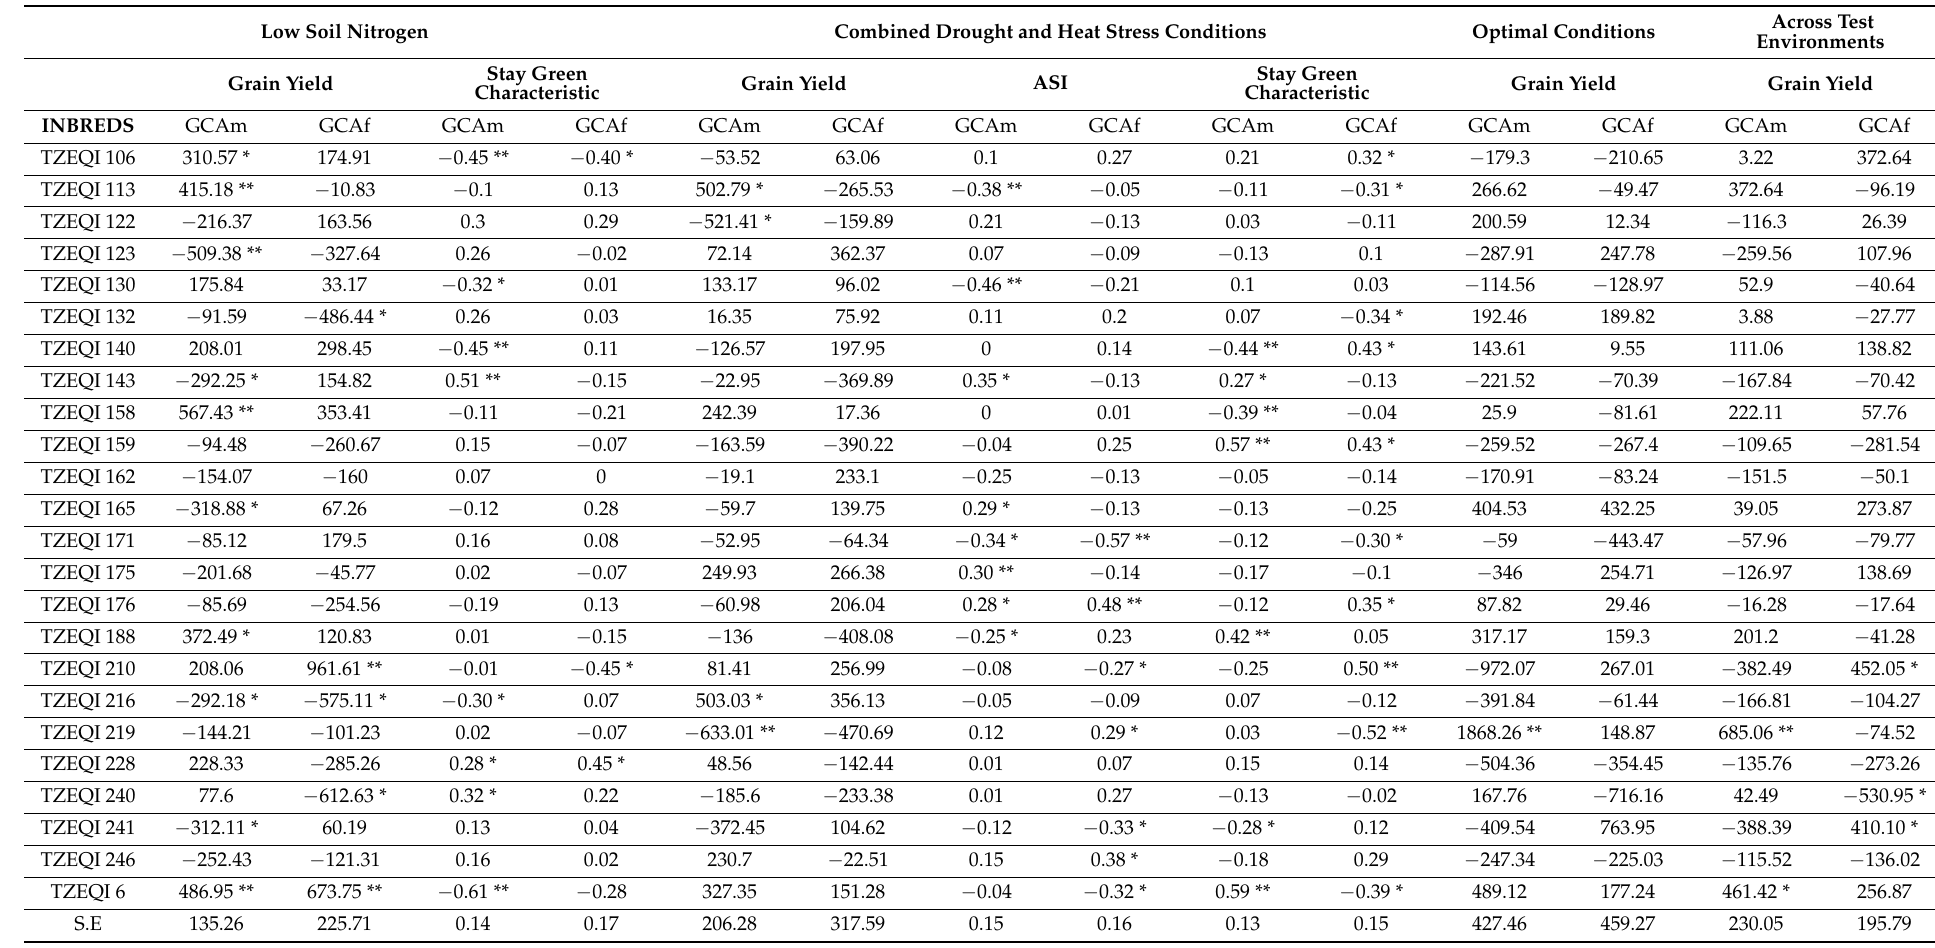
Table 4. GCA effects of the 24 early QPM inbred lines for grain yield and other agronomic traits evaluated under CDHS, low soil nitrogen, optimal and across test environments. Low Soil Nitrogen Combined Drought and Heat Stress Conditions Optimal Conditions